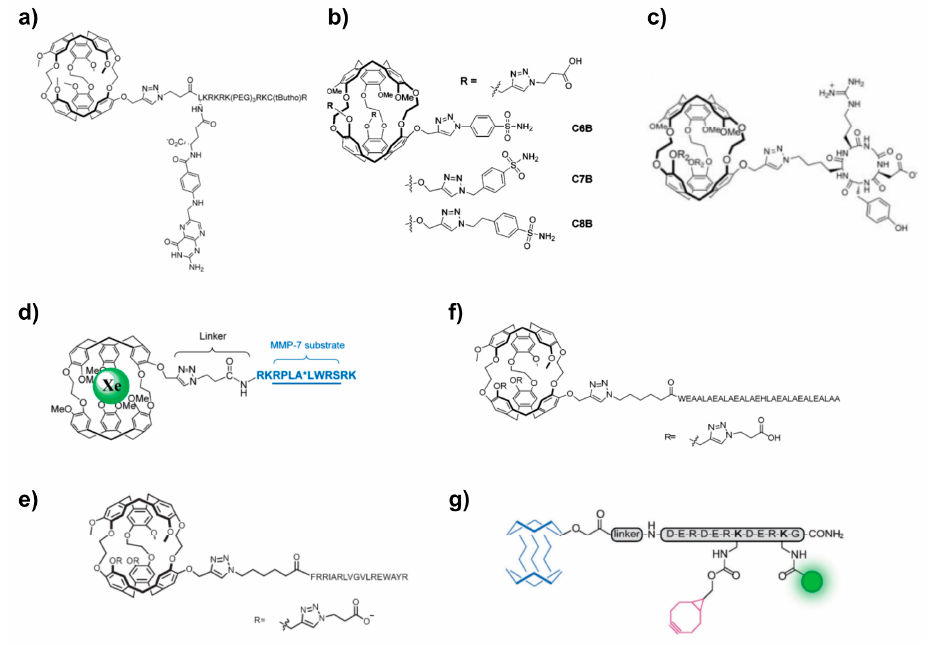
Figure 7. Exemplary cryptophane-A-based targeted 129 Xe biosensors discussed in this review. These biosensors were developed for investigating the following cellular targets: ( a ) folate [176] ( b ) carbonic anhydrase [177] ( c ) integrin [127] ( d ) matrix metalloproteinase-7 [148] ( e ) calmodulin [178] ( f ) cellular pH change response [179], and ( g ) glycans [128], respectively. Figures reproduced with permission from respective journal publishers.